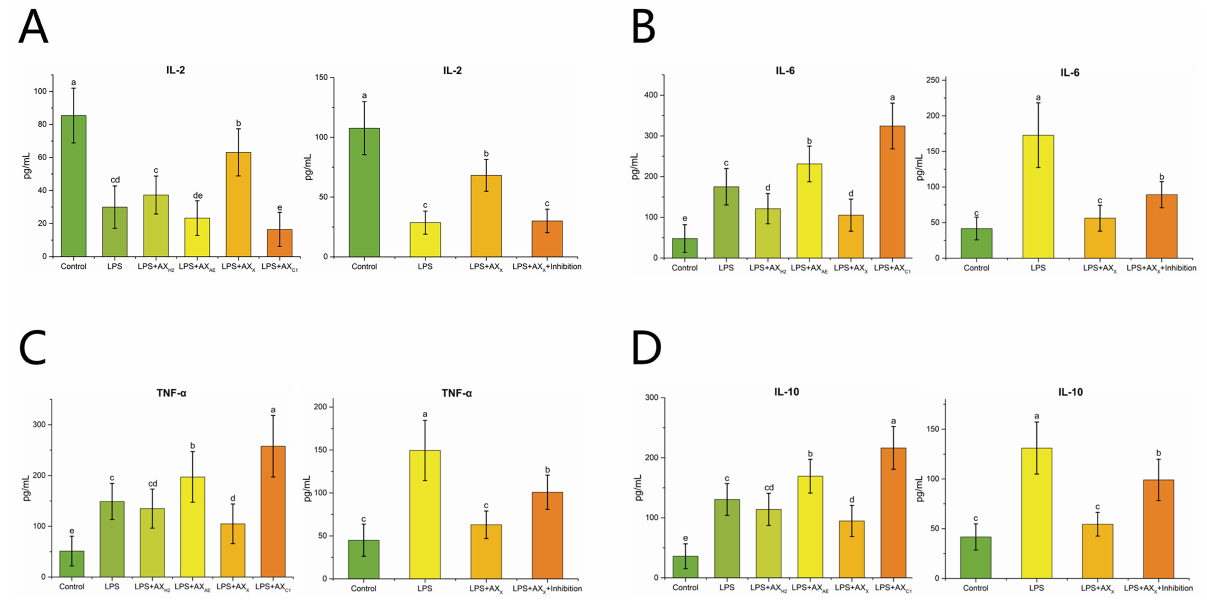
Figure 7. The effect of AXHs and MyD88 inhibitor on the expression of IL-2 ( A ), IL-6 ( B ), TNF- α ( C ), IL-10 ( D ) in LPS-induced Caco-2 cells Control, without LPS or arabinoxylan hydrolysates; AX AE , triticale bran arabinoxylan was treated with α -L-arabinofuranosidase; AX X , triticale bran arabinoxylan was treated with endo-1,4- β -xylanase; AX H2 , triticale bran arabinoxylan was treated with 0.15 M HCl; AX C1 , triticale bran arabinoxylan was treated with 0.1 M citric acid; Inhibitor, MyD88 inhibitor. Values represented in this figure consist of mean ± standard deviation ( n = 3). Values with different superscript letter are significantly different ( p <